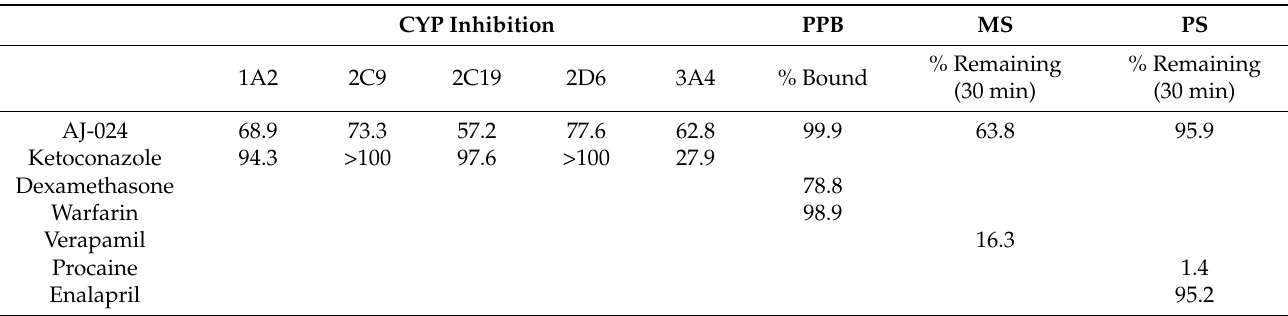
Table 4. In vitro ADME profile of AJ-024.